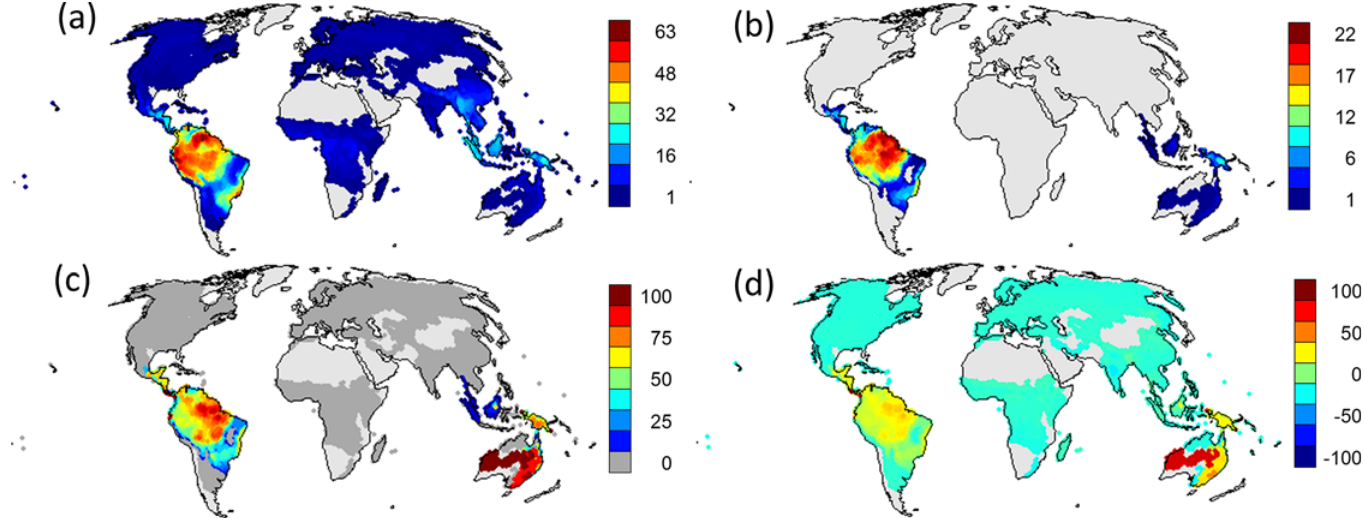
Fig 1. Global Distribution of Frugivory and Parental Care Mode. Global species richness of (a) frugivore passerine bird species ( n = 561) and (b) frugivore passerine bird species that display female-only parental care ( n = 109). (c) The proportion of frugivore passerine bird species that display female- only care and (d) the results of a permutation test estimating the likelihood of these proportions occurring by chance alone. Values range from 100 (red), higher than expected, to -100 (blue), lower than expected. Information in each map is summarized within equal-area cells of a global icosahedron (spatial resolution = 12,452 km 2 ) and the map projection is